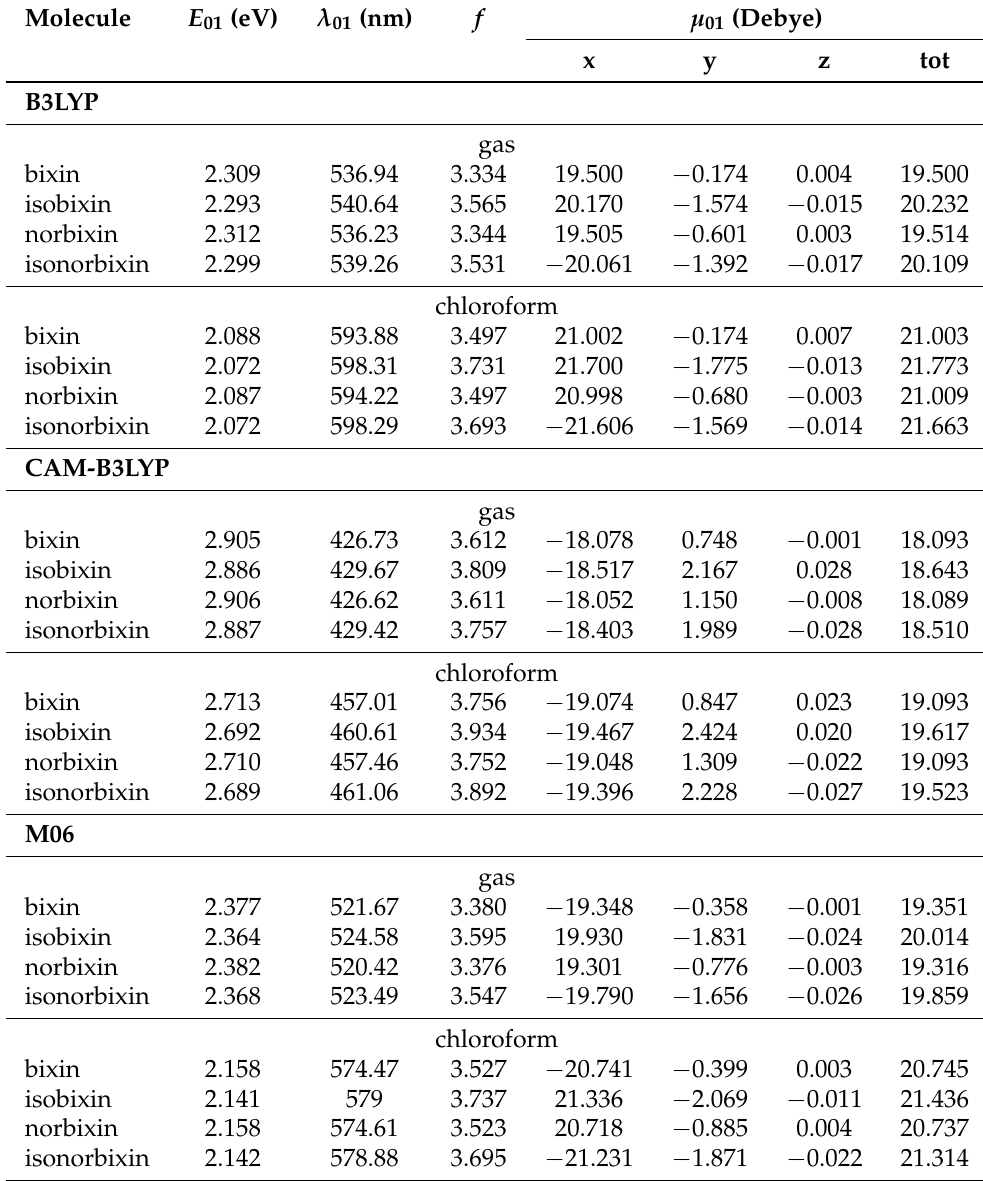
Table A18. S 0 → S 1 vertical transition energies ( E 01 ), wavelength ( λ 01 ), oscillator strength ( f ), and transition dipole moments ( µ 01 ). These results were obtained by employing the 6-31G(d,p) basis